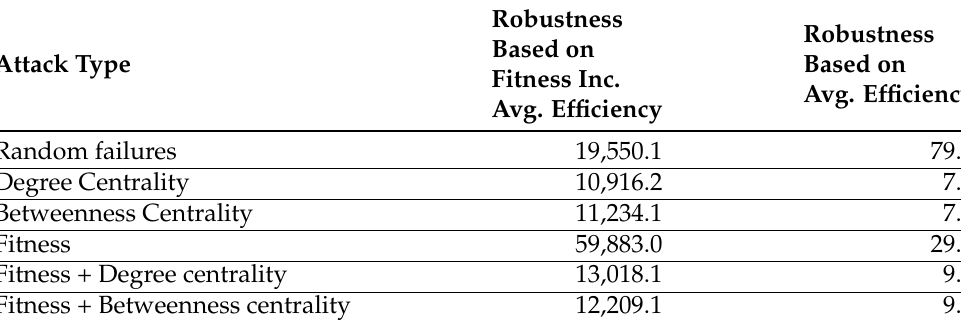
Table 11. Robustness analysis of the air traffic network, N =